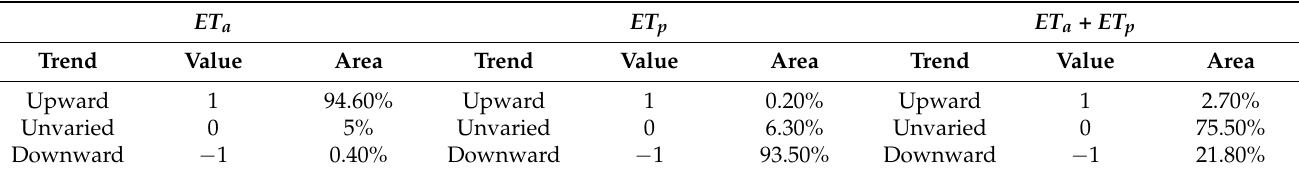
Table 5. Variation trend of AET, PET and the sum of AET and PET.